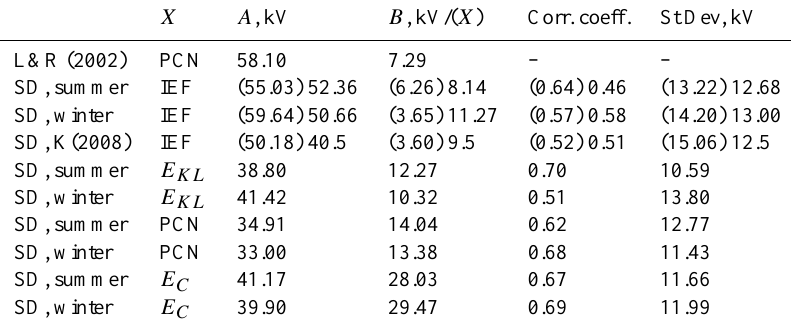
Table 1. Parameters of the linear fit line CPCP = A + B · X .